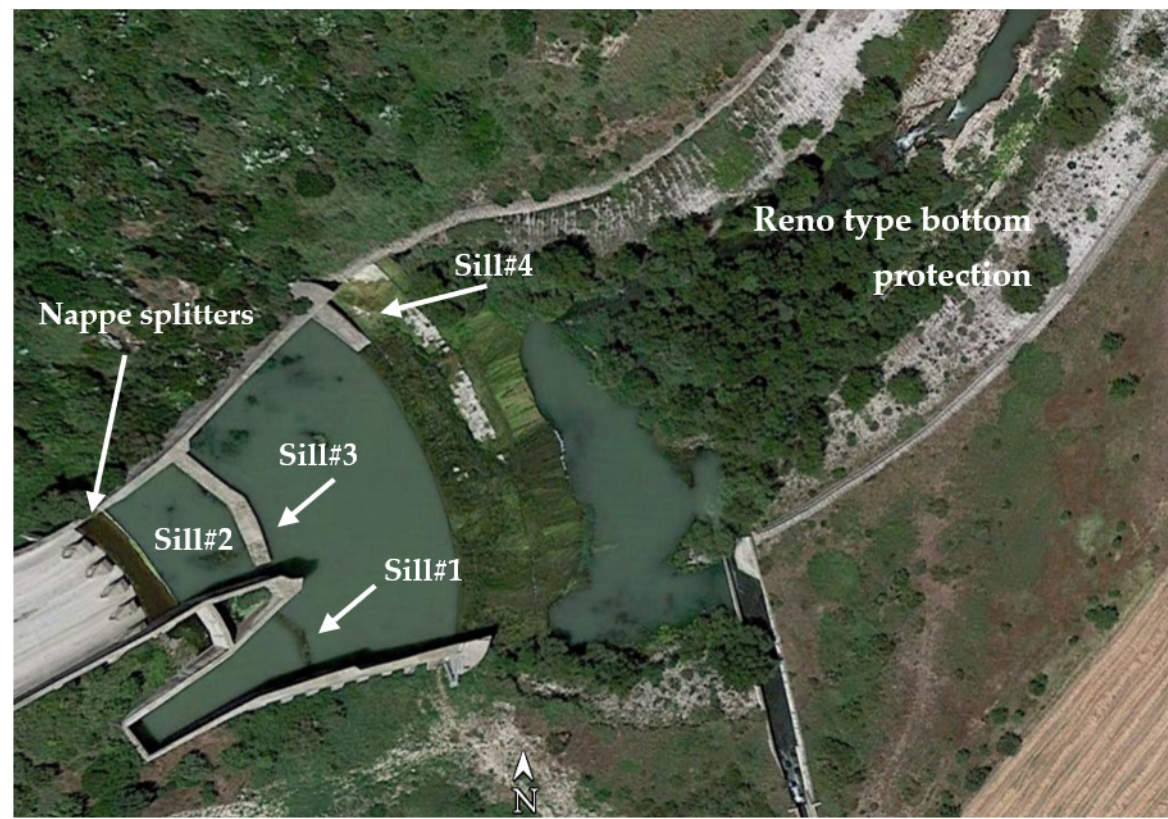
Figure 3. Dam elements aimed at reducing the kinetic energy of water drained into the stilling